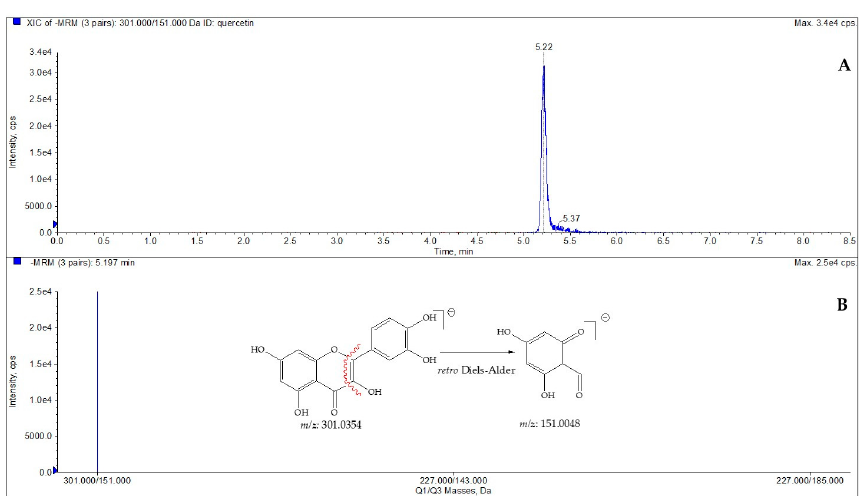
Figure 1. LC-ESI/QTrap/MS/MS spectrum of quercetin. The representative extracted ion chromatogram (XIC) of multiple-reaction monitoring (MRM) chromatogram of quercetin (A) and MRM MS spectrum of quercetin with the diagnostic fragmentation at m/z 151.0048 (B). Table 3. Quercetin content (µg) in the epigean parts of C. spinosa.